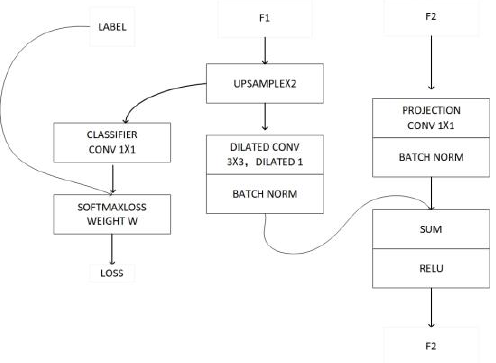
Figure 5 . Feature maps F1 and F2 are fused through CFF . Figure 5. Feature maps F1 and F2 are fused through CFF.